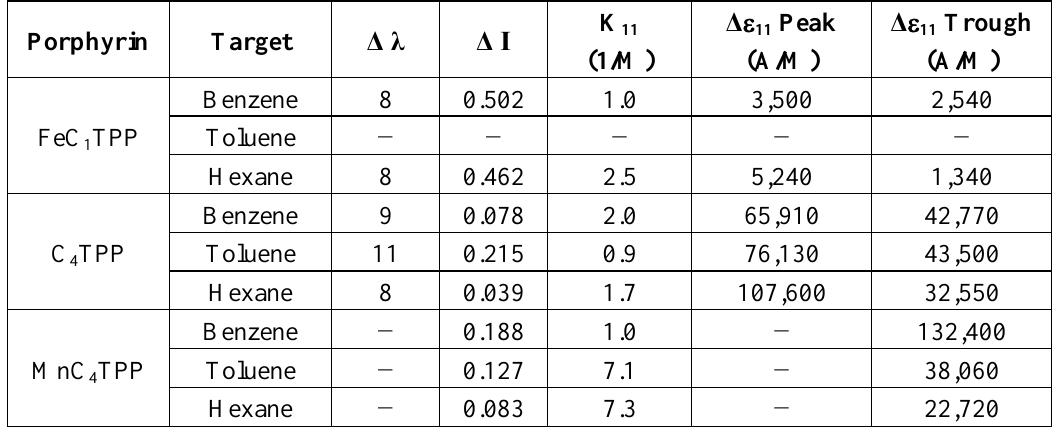
Table 2 . Interaction of porphyrins with targets in solution. ∆  and ∆I calculated based on absorbance changes for porphyrins (4 μM) in the absence/presence of targets (200 mM, in 95% methanol) using the rapid screening protocol. Association constants and extinction coefficient changes calculated from binding isotherms generated for porphyrins (3.3 μM) exposed to targets in methanol. Data for additional metalloporphyrins is provided in Supporting Information, Tables S2 and